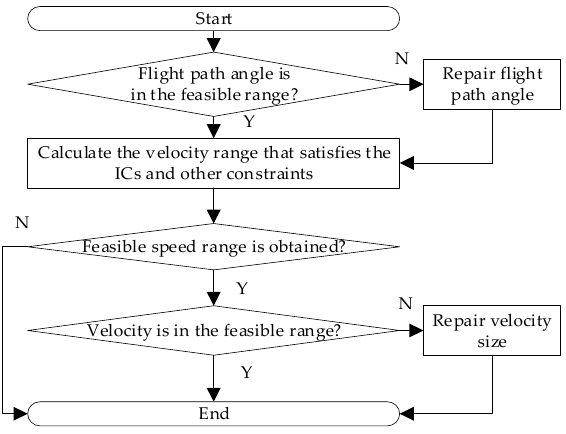
Figure 4. Flow chart of repairing ICs.